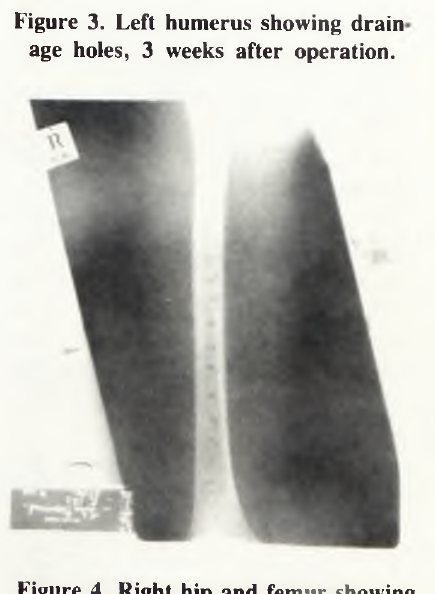
Figure 4. Right hip and femur showing drainage holes and calcification